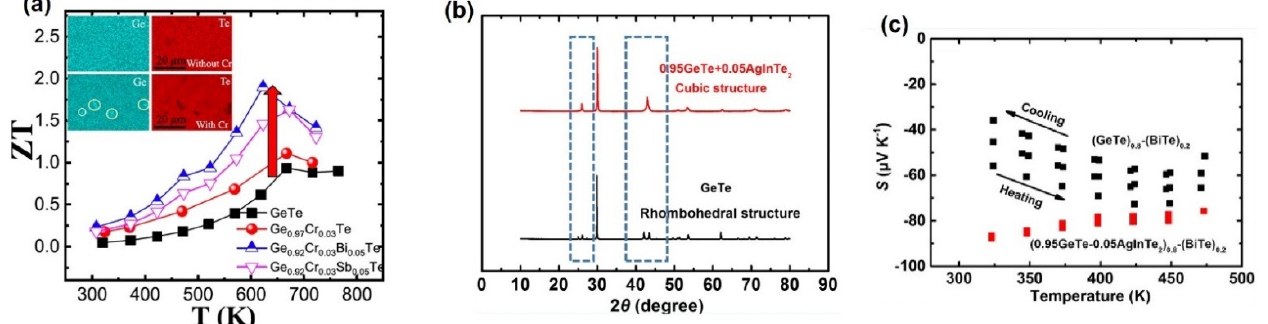
Figure 7. Examples of defect engineering in GeTe; ( a ) Cr doping to lower defect formation energy to create precipitations and defects to selectively lower thermal conductivity to enhance ZT [81], ( b ) high entropy AgInTe 2 alloying to stabilize the defect-prone cubic phase ( c ) enabling heavy Bi doping for firt stable n-type in GeTe [83].